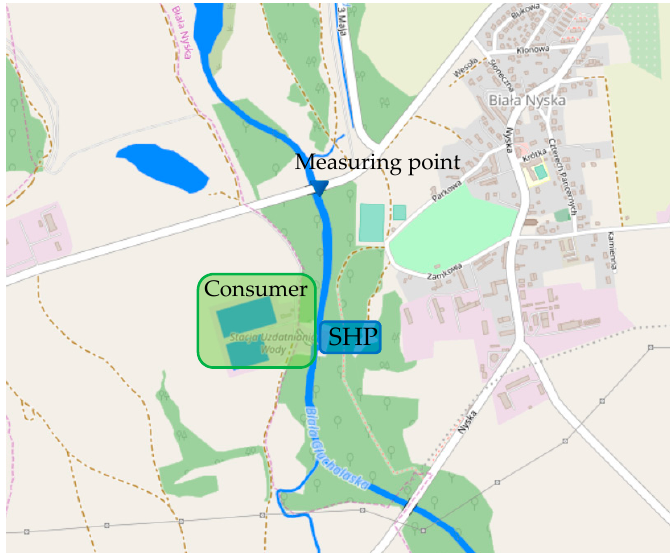
Figure 10. Location of the SHP, water intake and pumping station (consumer) and water level measurement point (Source: https://hydro.imgw.pl/#map/17.3033,50.432,15,true,false,0 accessed on 1 July 2021).